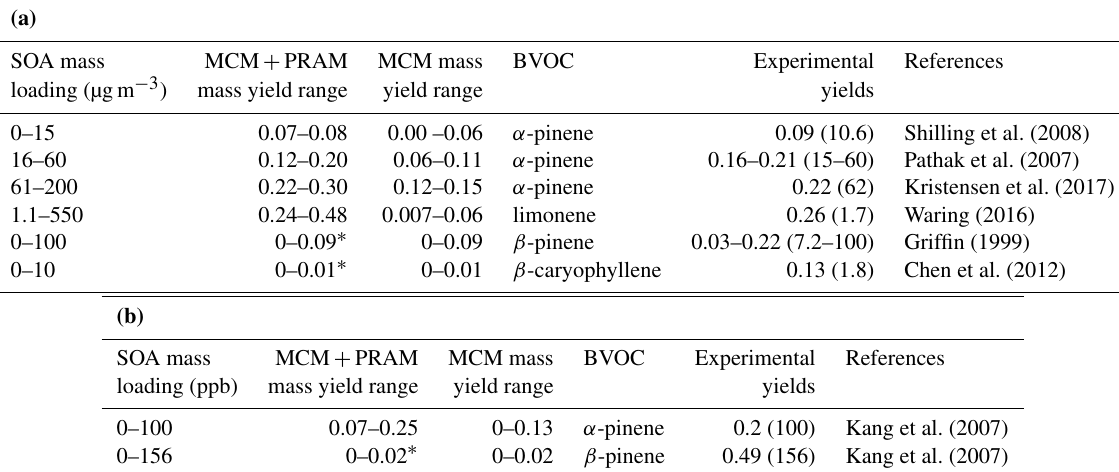
Table 2. (a) Mass yields for BVOC ozonolysis at 293K for different ranges of mass loadings using a chamber setup. The values in parentheses in the column “Experimental yields” indicate the corresponding experimental mass loadings in micrograms per cubic meter. (b) Mass yields for BVOC ozonolysis at 293K for different ranges of mass loadings using an OFR setup.